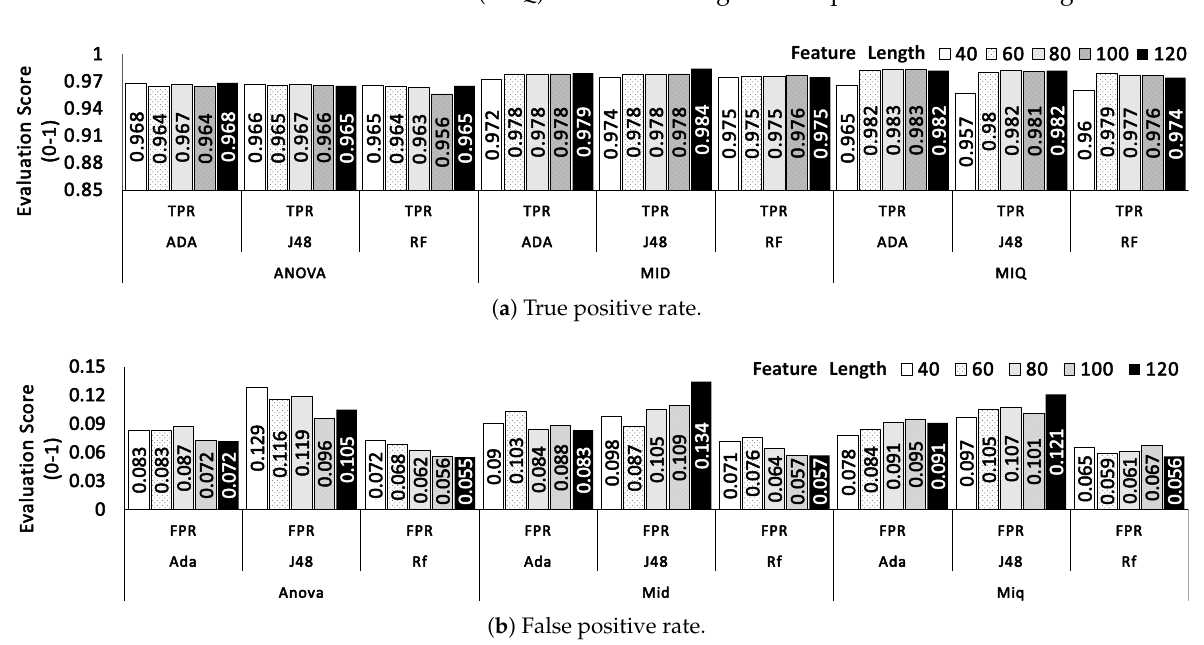
Figure 5. Performance of classifiers trained on API